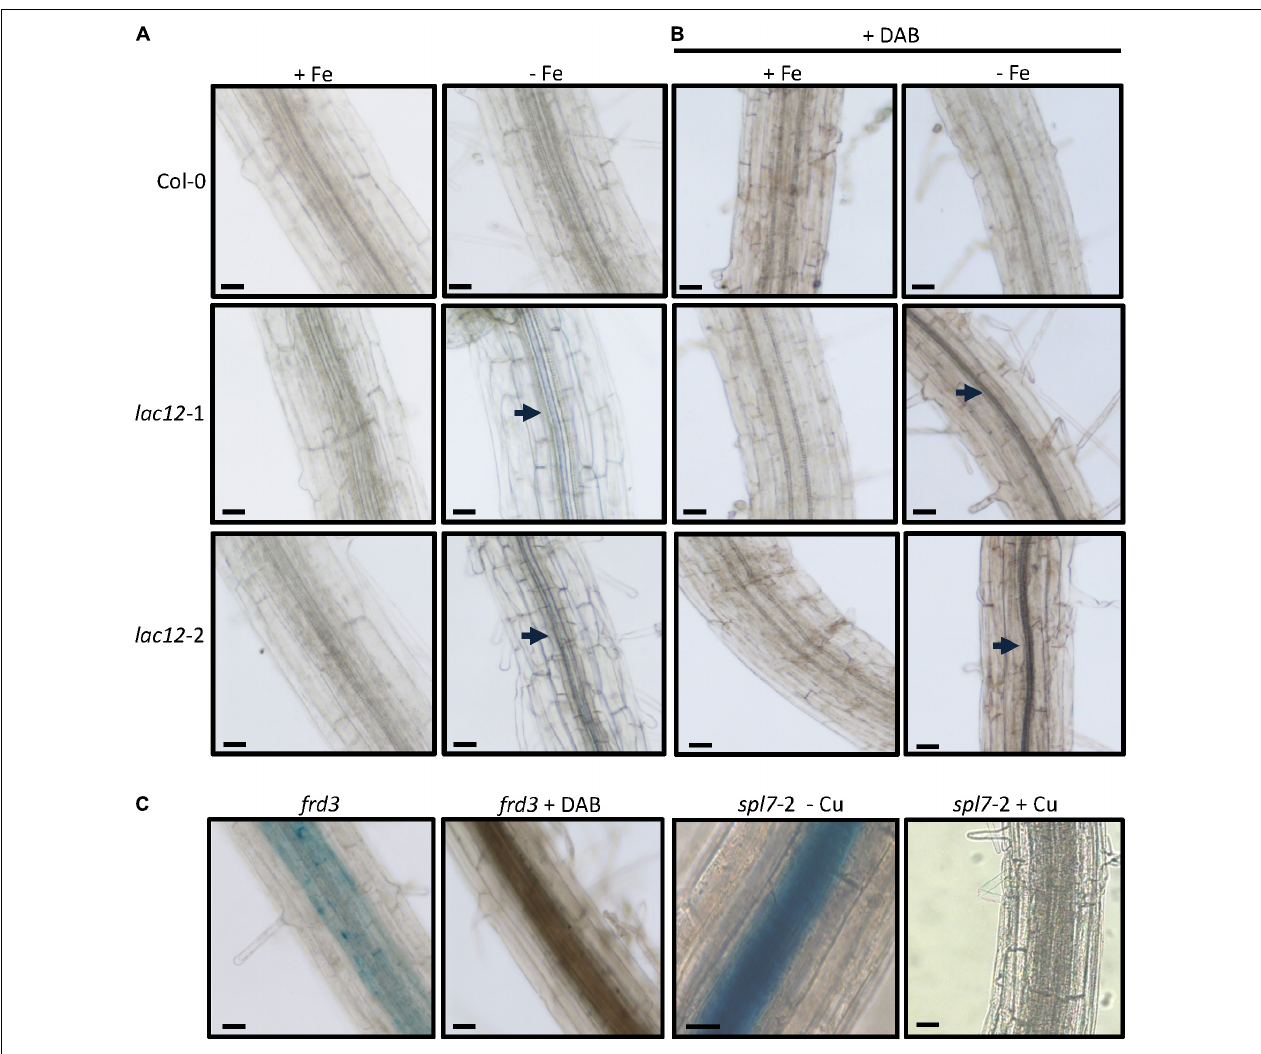
FIGURE 5 | Fe localization in roots of lac12 mutants. (A,B) Histochemical detection of Fe(III) by Perls’ blue stain in the root maturation zone of 7-d-old WT, lac12 -1 and lac12 -2 seedlings grown on Fe-sufficient (+Fe, 10 µ M FeHBED) or Fe-deficient (-Fe, 0 µ M FeHBED) agar-solidified Hoagland’s medium (EDTA-washed agar) without (A) or with DAB intensification (B) . (C) Histochemical detection of Fe(III) by Perls’ blue stain in the root maturation zone of frd3 and spl7- 2 seedlings. The frd3 mutant seedlings were grown only under Fe-sufficient conditions for 7 days. Images are of 21-d-old spl7 -2 seedlings grown on vertical glass plates containing EDTA-washed agar-solidified Hoagland’s medium (0.5 µ M CuSO 4 , control) or the same medium containing no added copper (-Cu) as described (Bernal et al., 2012). Photographs are representative of n = 10 to 12 roots stained and imaged in one experiment. Photographs are from one experiment representative of two independent experiments. Arrows point to Perls’ stain-positive regions. Scale bars: 50 µ